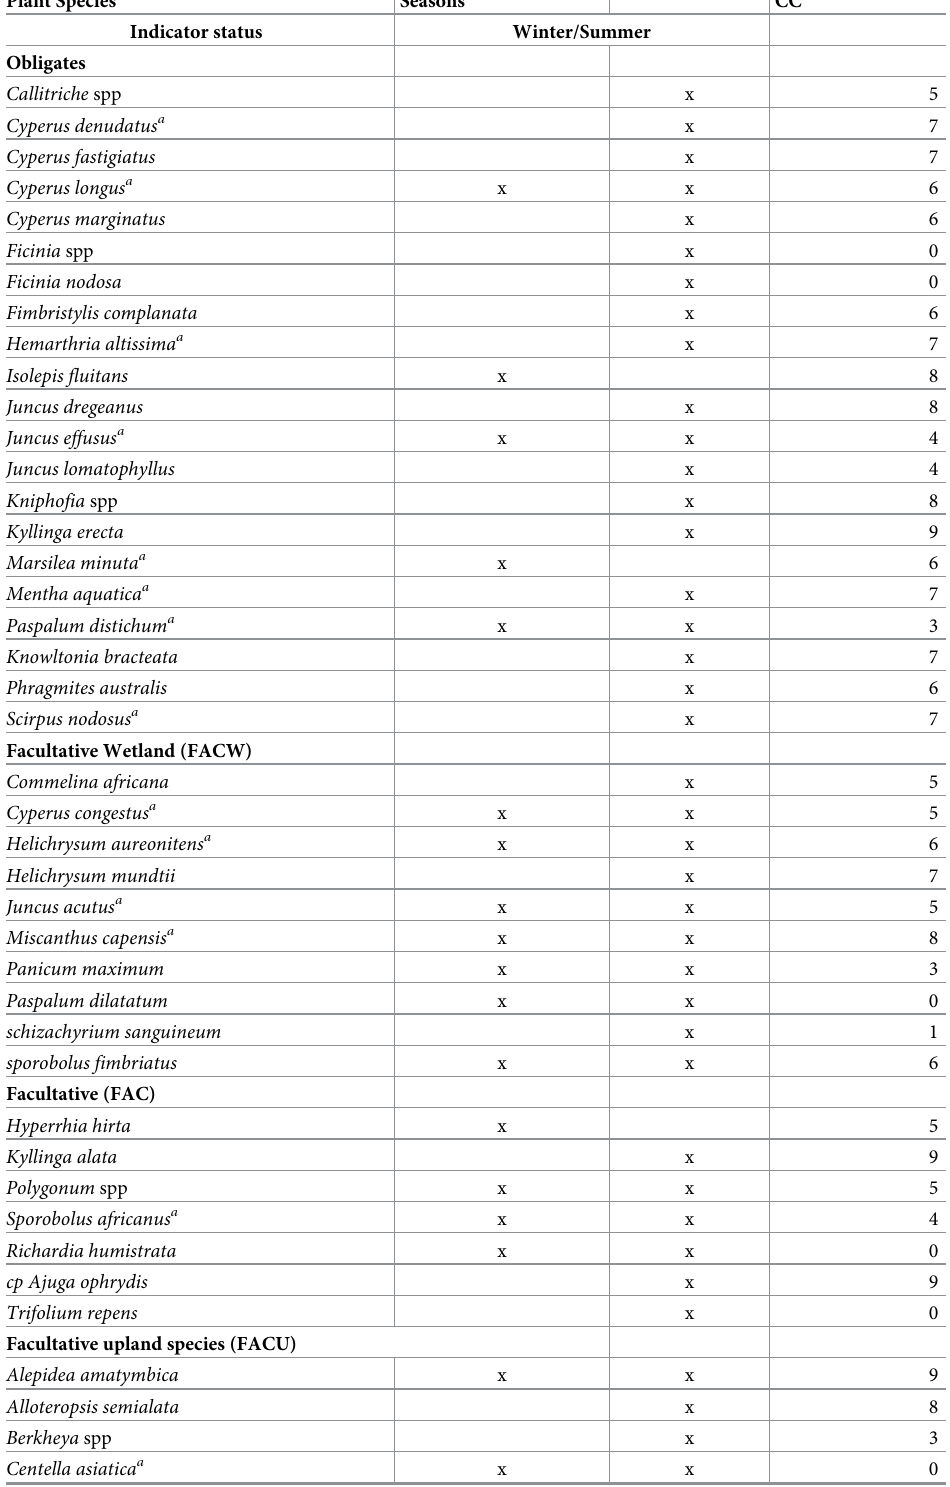
Table 5. Plant species present in all study sites with their assigned coefficient of conservatism and wetland indica- tor status. Species marked with superscript (a) are dominant, (x) indicates species